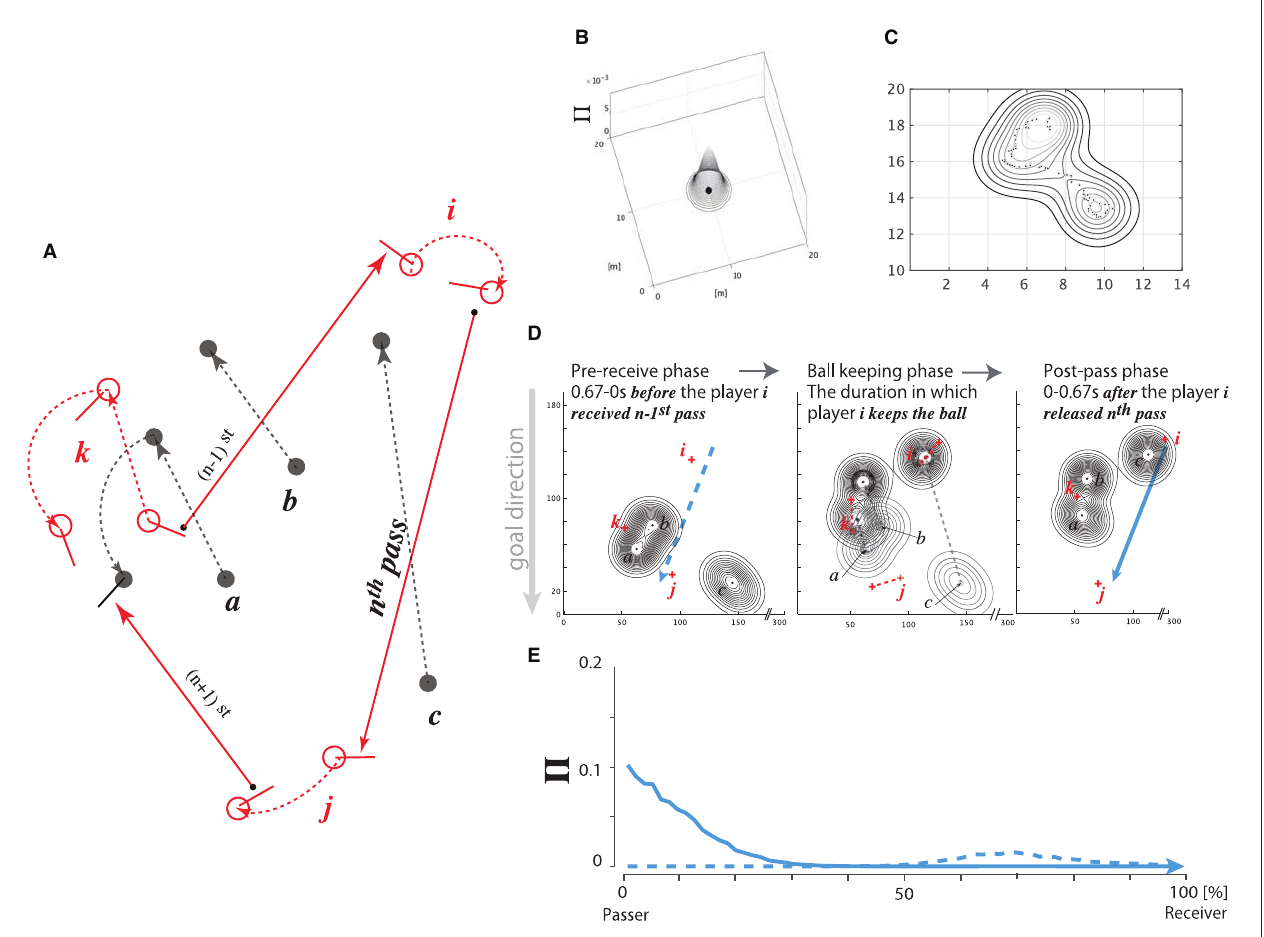
FIGURE 2 | Concept of defensive pressure ( 5 ) distribution. (A) Sequence from ( n − 1)st to ( n + 1)st passes fed from player k up to i and up to j . Attackers’ positions and their movements (red open circles, each with a stick and red dotted arrows; denoted as i , j , and k ), and defensive players’ positions and their movements (black filled circles, each with a black dotted arrow; denoted as a , b , and c ). Each trajectory, for the ( n − 1)st, n th, and ( n + 1)st passes, is represented by a red solid arrow ending with an arrowhead. (B–E) Procedure for calculating the fluctuation of defensive pressure on the pass trajectory. (B) 3D 5 distribution pressed by a defensive player positioned at an arbitrary position (for example, [10,10] in the figure) on the pitch coordinate. (C) Pressure distribution pressed by a defender moving along the trajectory of dots in a given duration ( dt seconds). (D) Three defenders’ pressure distributions (player a , b , and c , represented by black dots with contour) and attackers (player i , j , and k , diagrammed by red crosses) in the three action phases of the attacker i : pre-receive phase, ball-keeping phase, and post-pass phase. dt = 0.67 s for both the pre-receive and post-pass phases. Left : Attacker i is to receive the ( n − 1)st pass released by attacker k , and the three defenders are pressing on the pitch during the pre-receive phase. Blue broken arrow represents the n th pass released by attacker i up to attacker j in the postpass phase. Center : Attacker i is keeping the ball, and the defenders/attackers are moving to intercept/thread the n th pass, respectively. The pressure distributions are moving from a sparse contour plot to a dense plot during this phase. Right : Attacker i releases the n th pass to attacker j being pressed by the defenders in the post-pass phase ( dt = 0.67 s). Blue solid arrow represents the trajectory of the n th pass. Note that the n th pass trajectory is pressed differently in the pre-receive and post-pass phases. (E) : 5 distribution on the n th pass trajectory caused by the positions of the defenders in the pre-receive (blue broken plot) and post-pass (blue solid plot) phases. The values “0” and “100%” in the abscissa denote the positions of passer i and receiver j ,